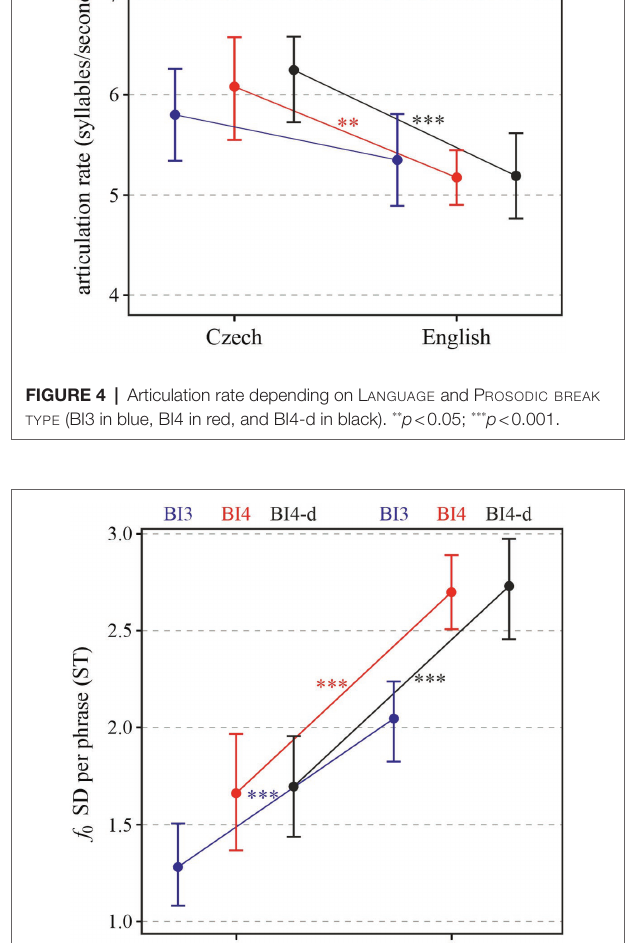
FIGURE 3 | Distribution of number of syllables per prosodic phrase depending on L anguage , only in BI4 phrases and with no disfluencies (BI4-d).